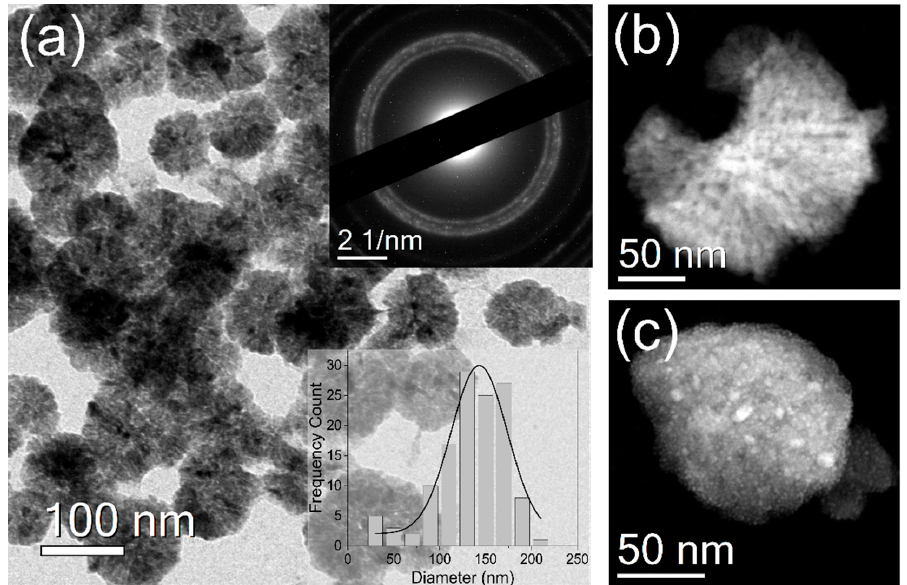
Figure 2. ( a ) Transmission electron microscope (TEM) image of the ZnO nanoparticles (NPs). The two insets show the selected area electron diffraction (SAED) pattern and the diameter size distribution of the NPs. Dark-field TEM images of ( b ) ZnO and of ( c ) ZnO decorated with Au NPs.